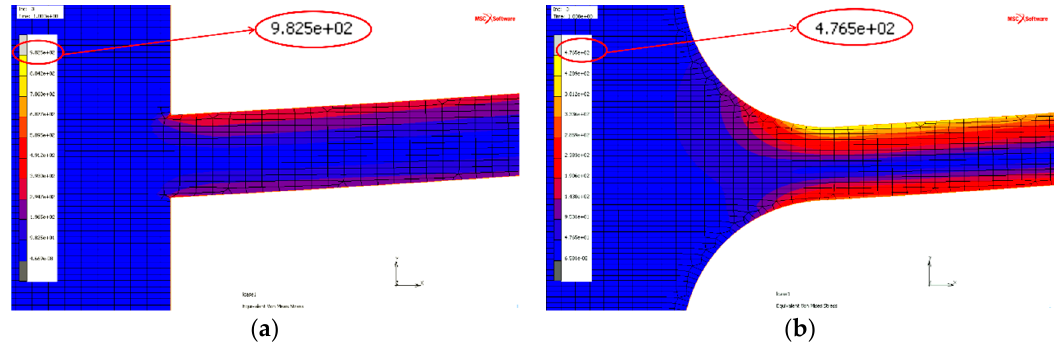
Figure 2. Map of equivalent von Mises stress: ( a ) sharp corner; ( b ) rounded